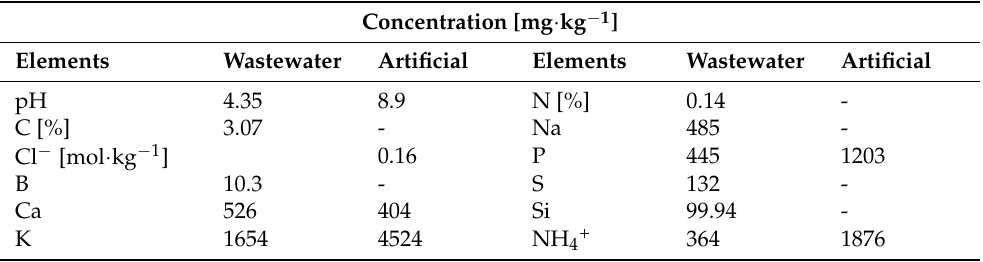
Table 1. Initial concentration of the artificial sample and its corresponding concentration in real